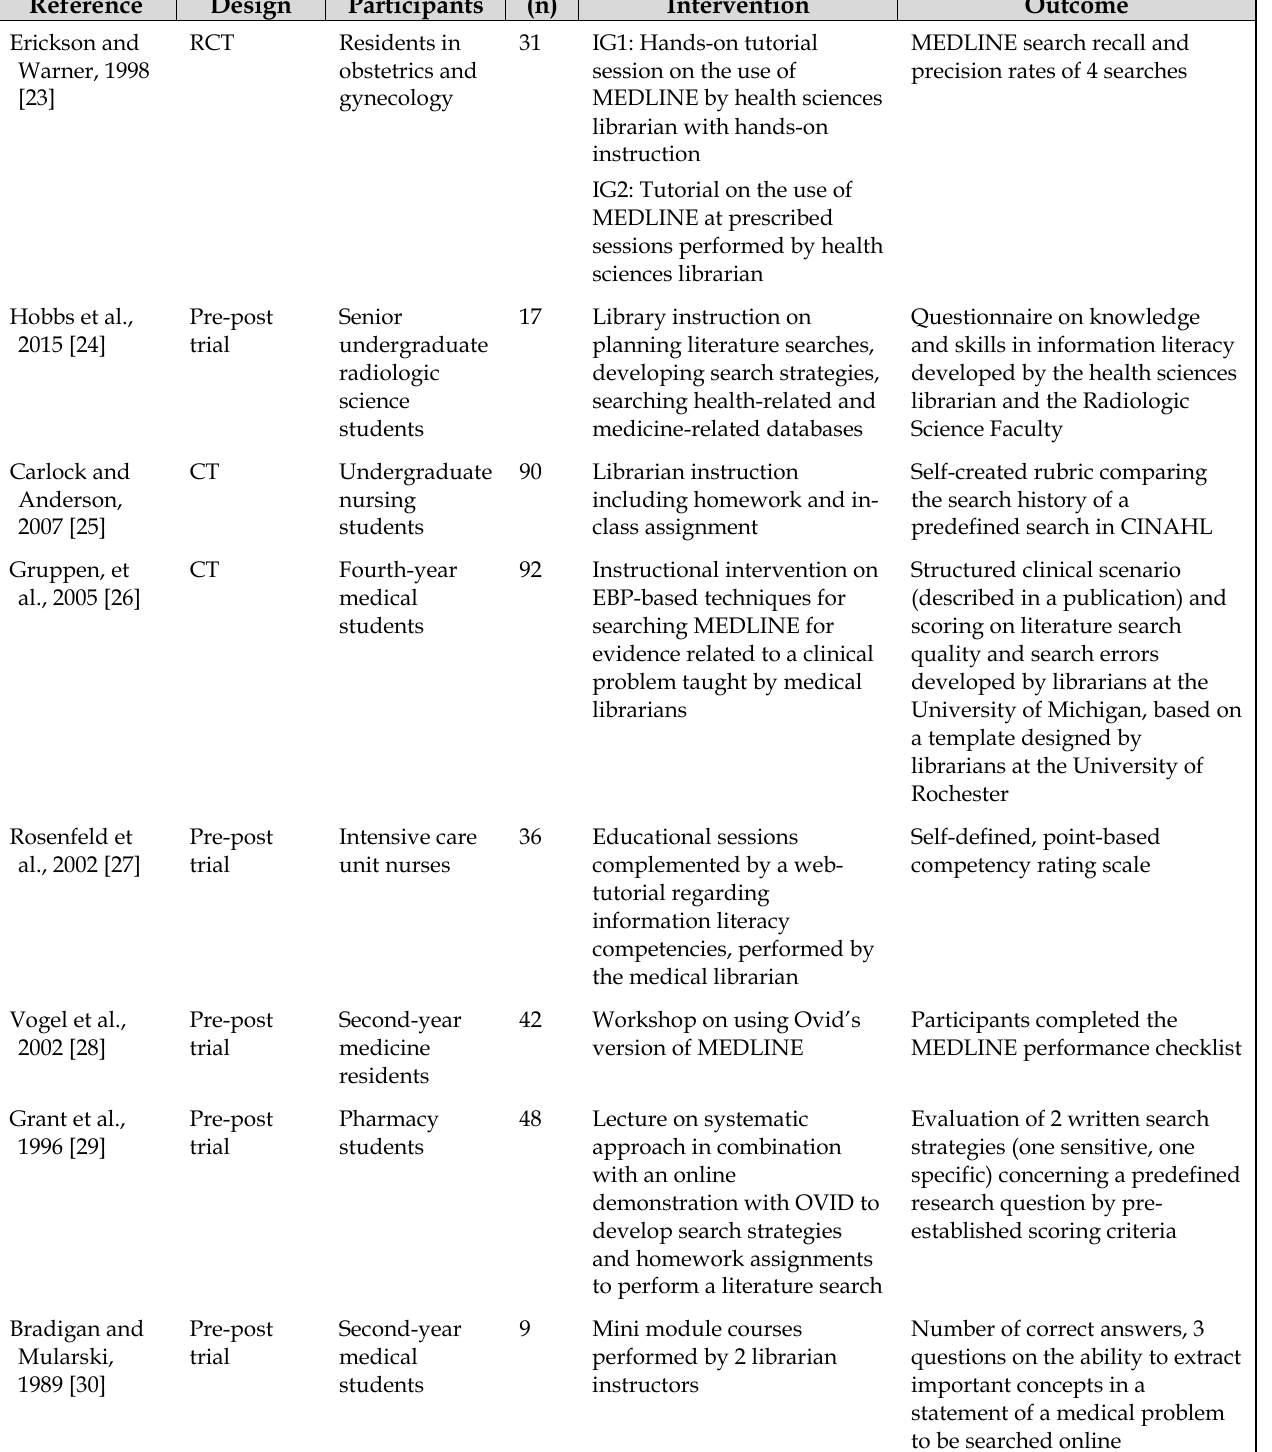
Table 1 Characteristics, interventions, and outcomes of included